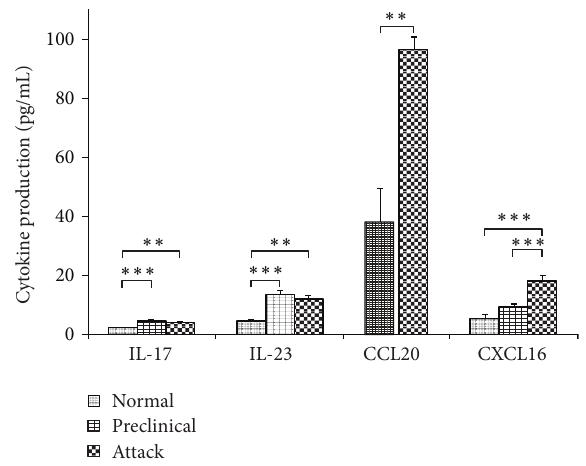
Figure 2: Cytokine production in the brain of EAE mice. Normal— healthy control mice, preclinical—immunized mice before disease onset, attack—second day of EAE symptoms. Data are presented as mean ± SEM. ∗ 0.05 ≥ 𝑃 ≥ 0.01 ; ∗∗ 0.01 > 𝑃 ≥ 0.005 ; ∗∗∗ 𝑃 < 0.005 .